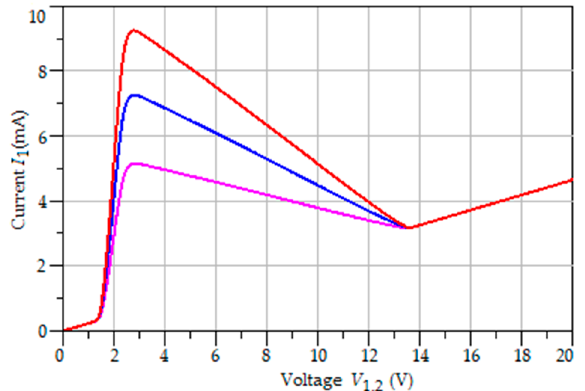
Figure 18. Current-voltage characteristics of the NDR circuit with multiple-output Wilson current mirror; m = 0—purple curve, m = 1—blue curve, m = 2—red curve.